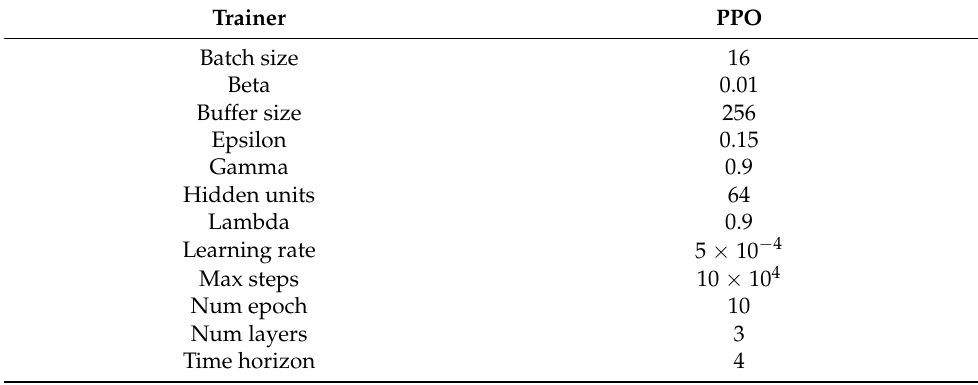
Table 8. Configuration hyperparameters for the IA trained by reinforcement through the PPO